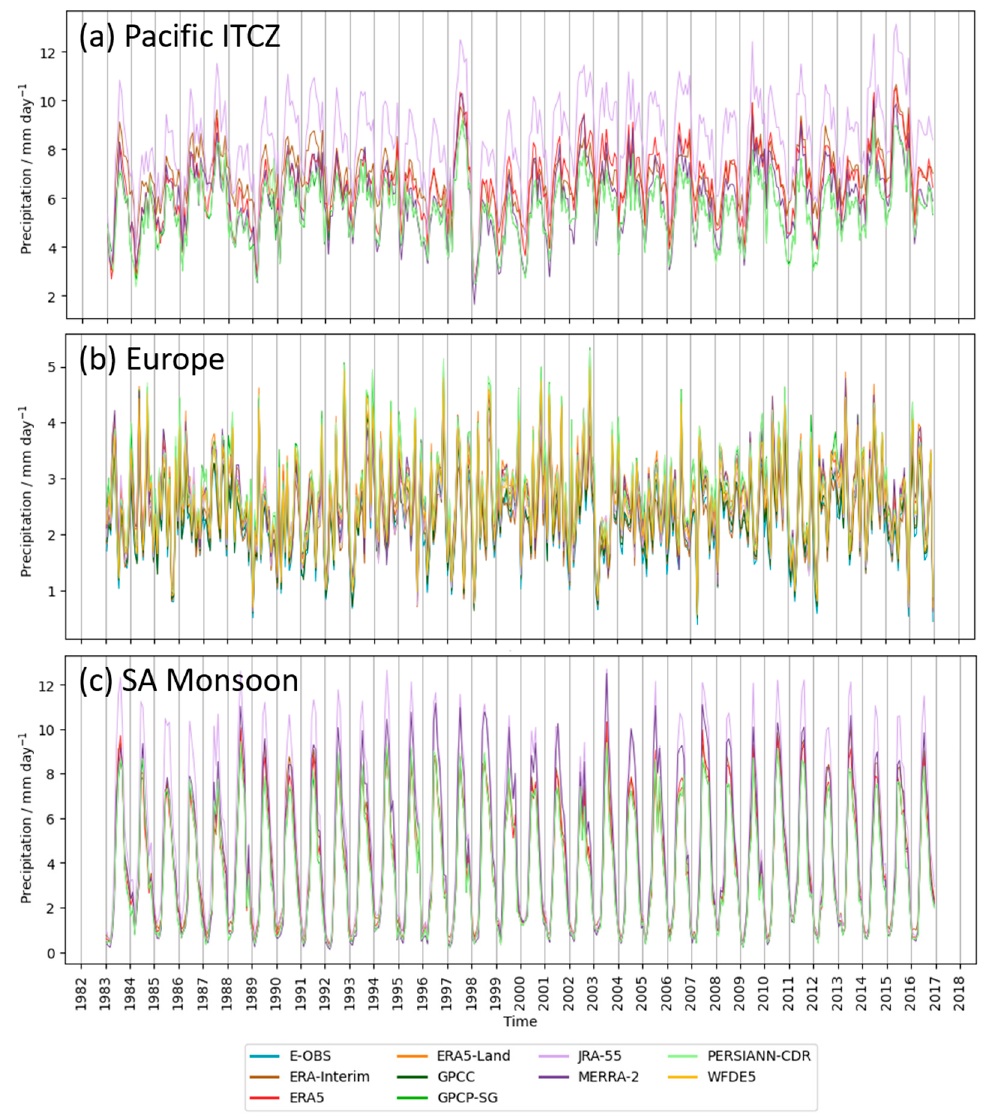
Figure 8. Times series of area averaged monthly mean precipitation rates for ( a ) the Pacific ITCZ, ( b ) Central Europe (including ERA5 ‐ Land, GPCC and WFDE5 data), and the ( c ) SA Monsoon region ( b ) Central Europe (including ERA5-Land, GPCC and WFDE5 data), and the ( c ) SA Monsoon region for the period 1983–2016. for the period